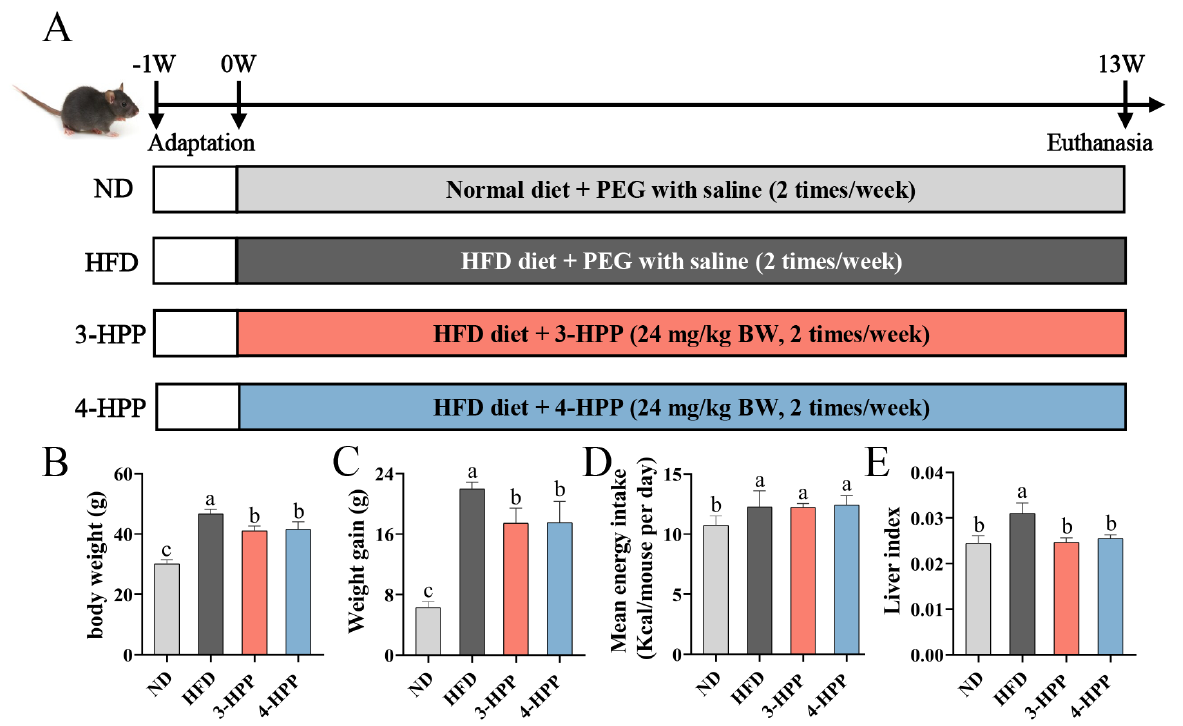
Figure 1. The influence of 3-hydroxyphenyl propionic acid (3 − HPP) and 4 − HPP on physiological indexes. ( A ) Schematic diagram of animal experiment period. ( B ) Final body weight (BW). ( C ) BW gain. ( D ) Energy intake. ( E ) Liver index. Data are expressed as mean ± SD. n = 6 if not specified. According to Duncan’s test, mean values with different letters mean significant differences at p < 0.05.